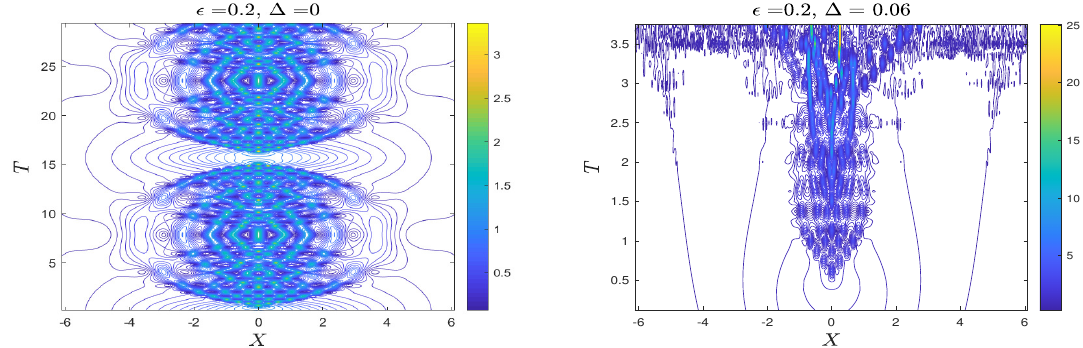
Figure 10. Case 3: The initial condition is (13) with γ = 0.5, (cid:101) = 0.1, M = 1 and ∆ = 0, ∆ = 0.06. The case when γ = 0.5, (cid:101) = 0.2 and ∆ = 0.00, 0.06 is shown in Figure 11. Here ˜ (cid:101) = 0.1, but in comparison with the previous case shown in Figure 10, without forcing there is no sign of the emergence of solitons, and instead a breather family forms and then reforms. However, in the forced simulations, solitons emerge as in the previous case in Figure 10 and as the forcing is increased, there is a transition to just a few stationary solitons with growing amplitudes.